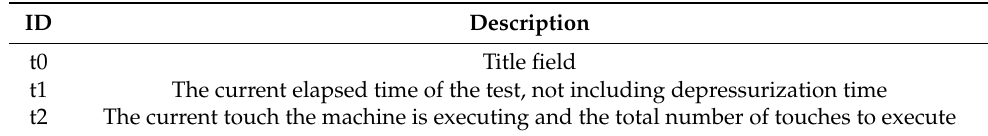
Table 5. Description of each text field found on the test page.